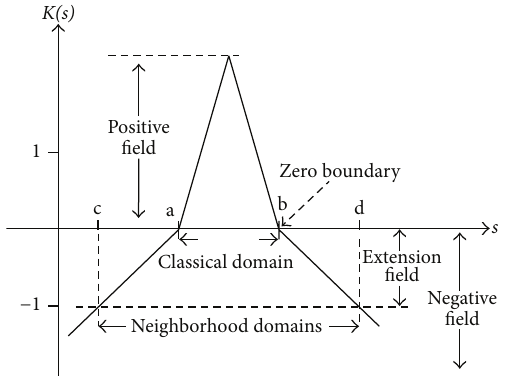
Figure 1: Schematic diagram of the correlation function.